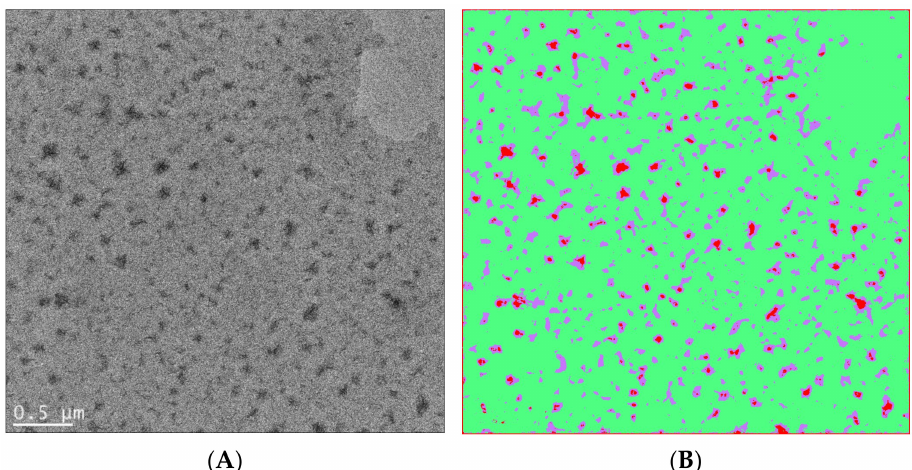
Figure 10. ( A ) Bright-field TEM image of a polyvinylidene fluoride (PVDF)-block-polystyrene (PS) block copolymer film showing crystalline domains in darker regions. The volume fraction of the PVDF block is 20% in the PVDF-b-PS copolymer. (The copolymer was provided by Alex Asandei, University of Connecticut.) ( B ) An attempt to classify PVDF-b-PS crystalline domains (red) and amorphous domains (green), as well as their interfaces (purple), by using the Fiji package of Image J and the machine learning capability of the Weka plugin. The Weka program is based on [102]. The Weka program was trained by user-predefined regions and then used a chosen algorithm to automatically classify each pixel. For the case of PVDF-b-PS, a fast random forest method was used to perform image segmentation, which also yields probability maps and threshold curves for performance evaluation.